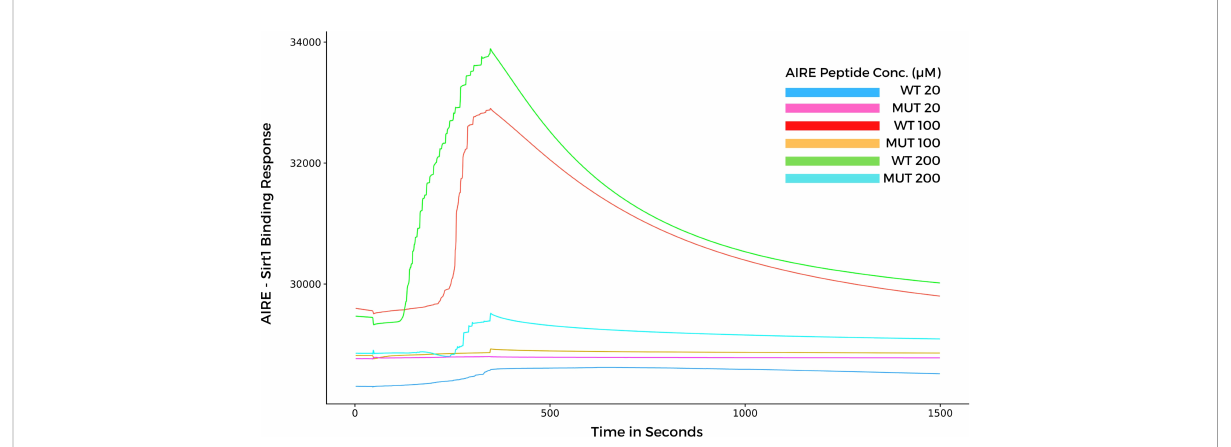
FIGURE 6 Surface plasmon resonance sensorgrams for binding the AIRE SAND domain with SIRT1 protein immobilized onto a Biacore sensor chip. The SAND domain peptides were assayed at various concentrations (20, 100, and 200 µM) with a contact time of 300 seconds, a 20 m l/min fl ow, and a dissociation time of 1200 seconds. Note that the WT AIRE SAND peptide (Gly228) associated and dissociated with SIRT1 throughout the analysis, while the mutant AIRE SAND peptide (Trp228) exhibited lesser association af fi nity with SIRT1 when compared to the WT